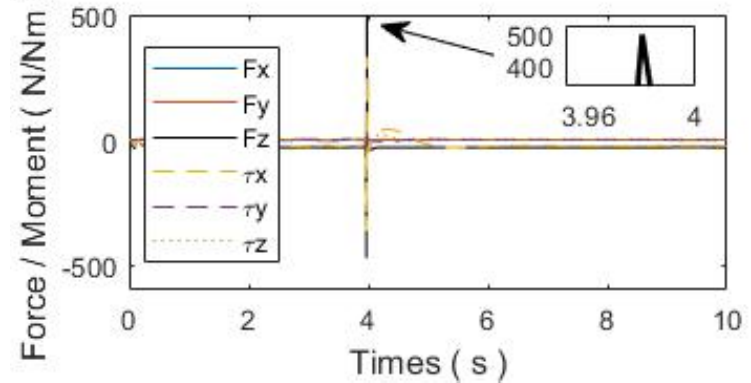
Figure 11. The contact force between shaft and hole in experiment 3. Figure 12. Disturbance of the base in experiment Figure 12. Disturbance of the base in experiment 3.